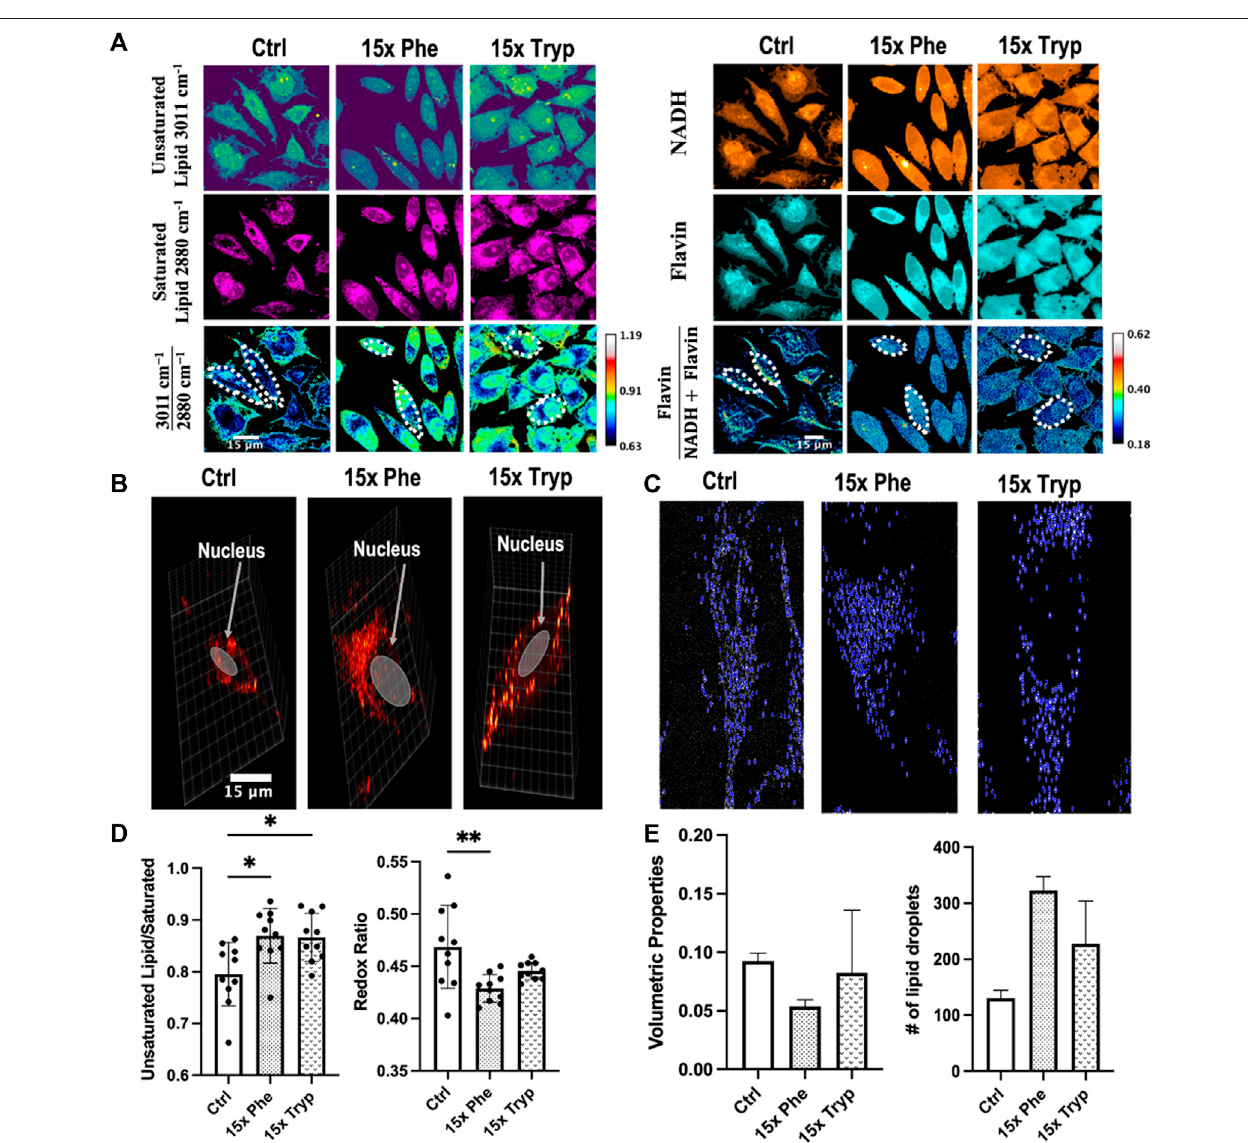
FIGURE 4 | Images obtained using label-free SRS and analyzed from the unsaturated fatty acids, saturated fatty acids, NADH, and Flavin channel to observe the auto fl uorescence between each experimental condition. (A) SRS microscope visualizes in vitro unsaturated fatty acid ( 3011 cm − 1 ) and saturated fatty acid ( 2880 cm − 1 ) channels, and 2PEF microscope visualizes in vitro Flavin and NADH channels in HeLa cells for control (ctrl), 15x phenylalanine (15x phe), and 15x tryptophan (15x tryp). Many cell units in the same regions of interest are used for calculating absolute intensities of 3011 cm − 1 intensityprojectionusingSRSimagestacks.LDsarehighlightedinbluecolorusingahome-madeMATLABscript. (C) ThevolumeandaveragenumberofLDsforcontrol and experimental conditions. Excess AAA LDs have a reduced size compared to control group; however, they have a greater number of LDs. (D,E) Quanti fi cations of 3011 cm −